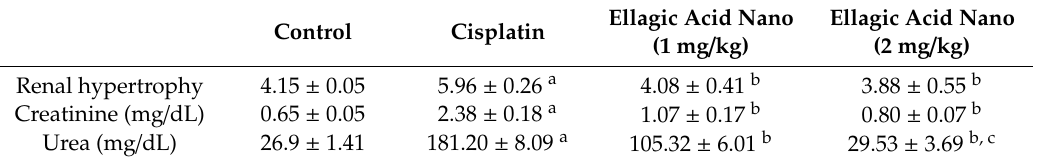
Table 1. Impact of ellagic acid nanoformulation on renal hypertrophy, serum creatinine, and urea measured in cisplatin-treated